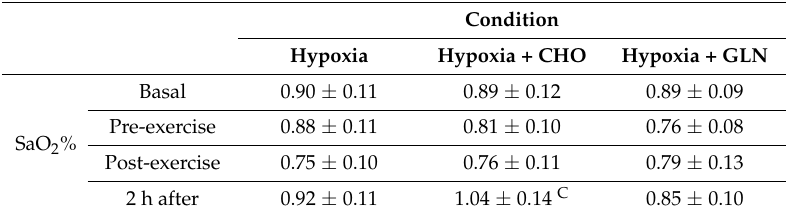
Table 2. Salivary Flow.